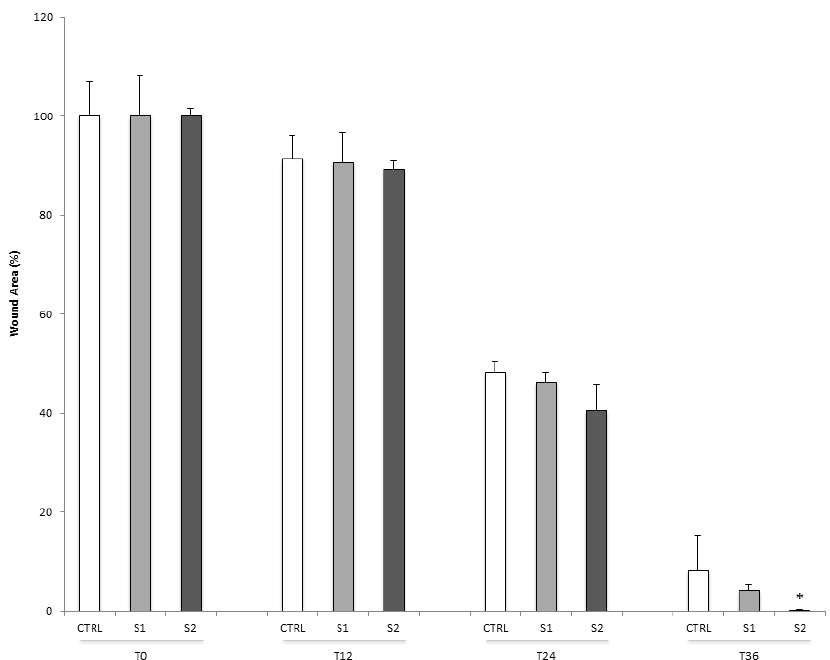
Figure 3. Quantification of wound healing in human corneal epithelial cells. The relative scratch gap was calculated as the percentage of the remaining wounded area at the given time point compared with the initially wounded area at 0 h. Data were expressed as mean ± SD ( n = 3). * p < 0.05 compared with control.